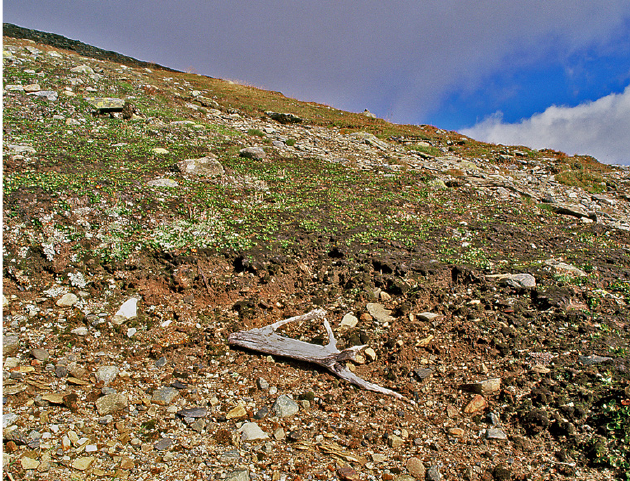
Figure 44: Subfossil pine unearthed by recent wind erosion in a snow poor high alpine environment. 10 350 cal. yr BP (Beta-184490). The site Mt. Getryggen, 1250 m a.s.l., is located 18 km northeast of Storsylglaciären (3) and 500 m above the present-day pine